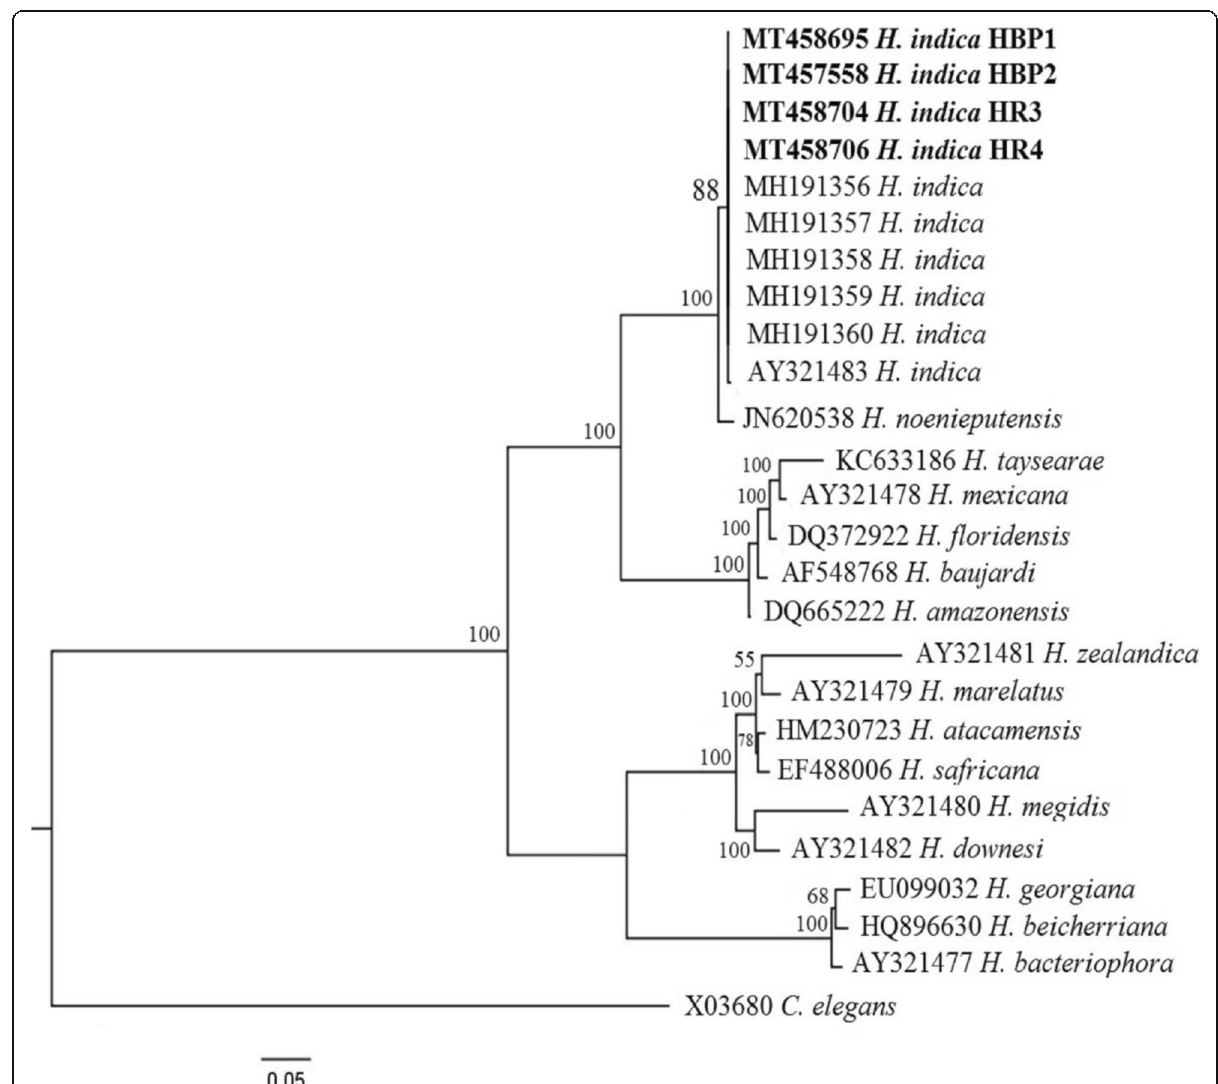
Fig. 1 Bayesian inference tree previously and newly sequenced Heterorhabditis indica (bold) and other type described species of Heterorhabditis based on sequences of Internal Transcribed Spacer (ITS1-5.8S-ITS2) rDNA region. Bayesian posterior probabilities (%) are given for each clade. The scale bar shows the number of substitutions per site. Caenorhabditis elegans was used as an outgroup